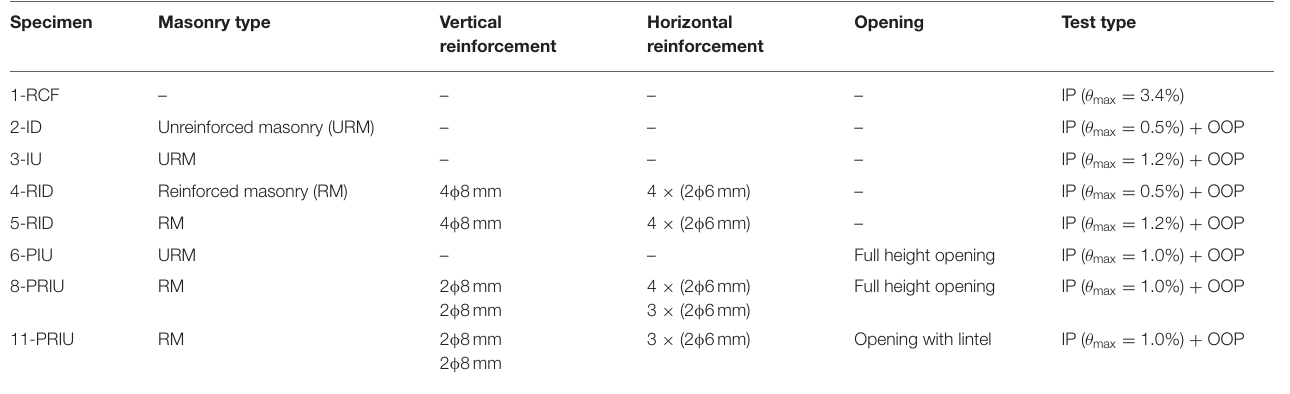
TABLE 3 | In-plane (IP)–out-of-plane (OOP) test program on full-scale specimens.